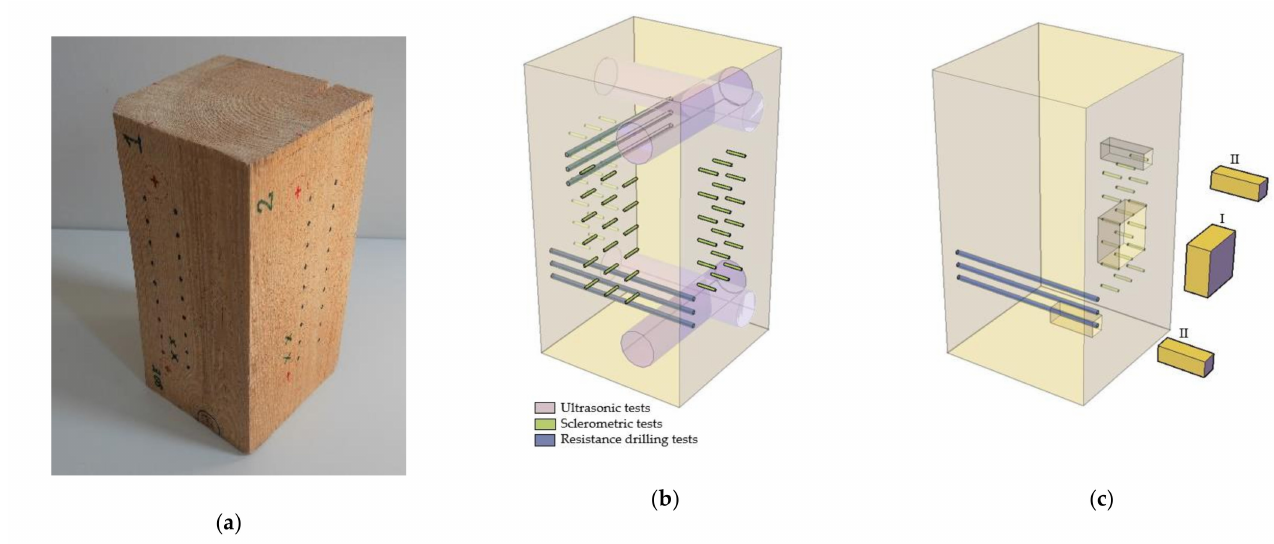
Figure 4. ( a ) Example of a sample; ( b ) Schematic view of test field distribution; ( c ) Illustration of locations of samples for determination of area density in the absolute-dry state (I) and tomography imaging studies (II).